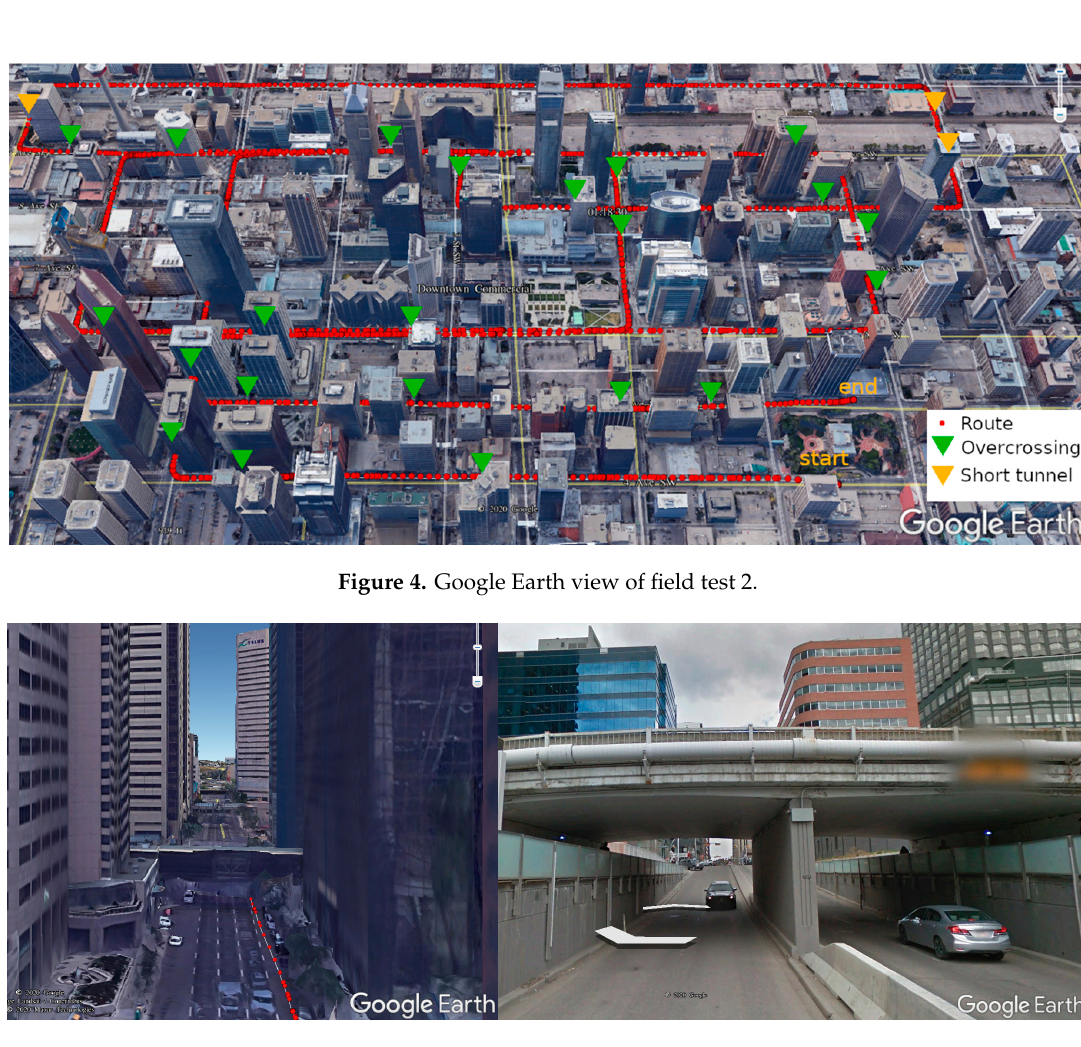
Figure 5. Demonstration of the overcrossing ( left ) and short tunnel ( right ) in Google Earth View. Table 1. Parameter values used in the weight